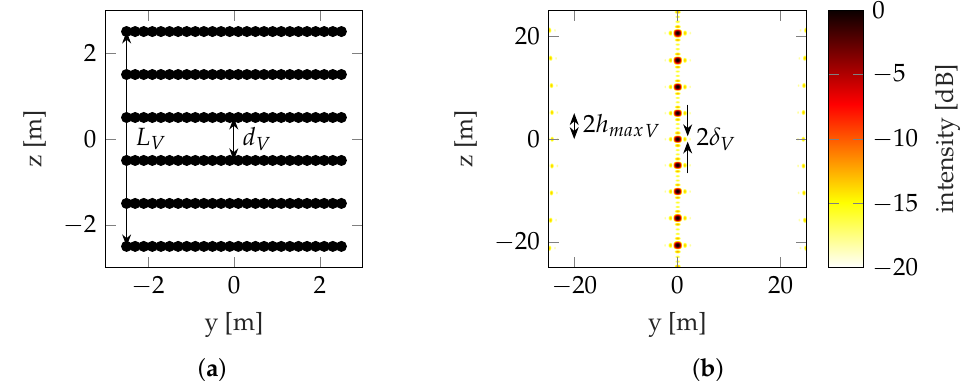
Figure 4. CSAR/MBSAR example: ( a ) Trajectory. ( b ) PSF. L V is the vertical synthetic aperture size (the distance between the highest and lowest pass) and d V is the vertical sampling distance (the distance between consecutive